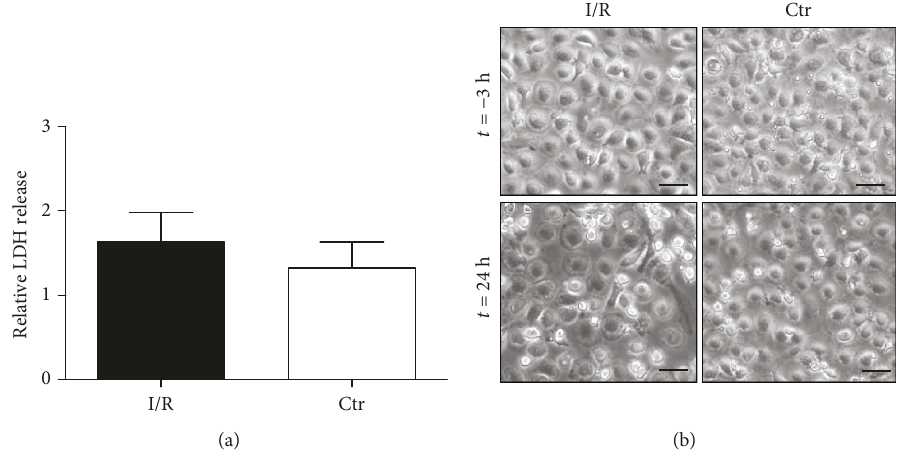
Figure 2: E ff ects of I/R on LDH release and morphology of Mreg. (a) Relative LDH release. (b) Phenotypic characterization of Mreg. Scale bars in the photomicrographs denote 40 μ m. I/R: ischemia/reperfusion; Ctr: control; N = 14 .